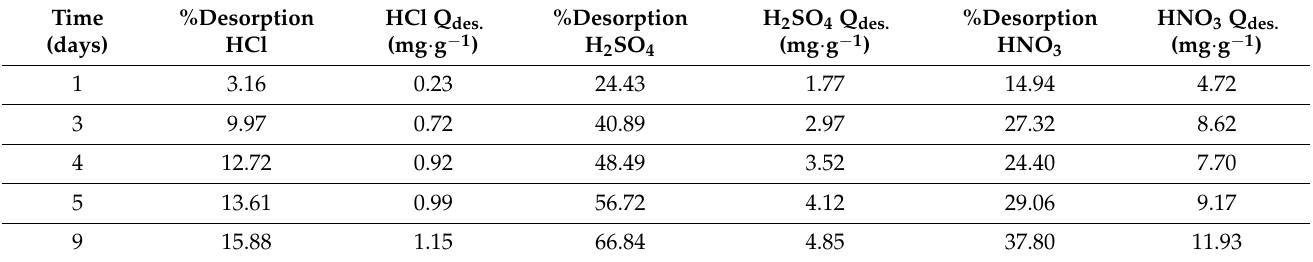
Table 1. Percentage desorption of Cr(III) and Q des. with different acidic extractant